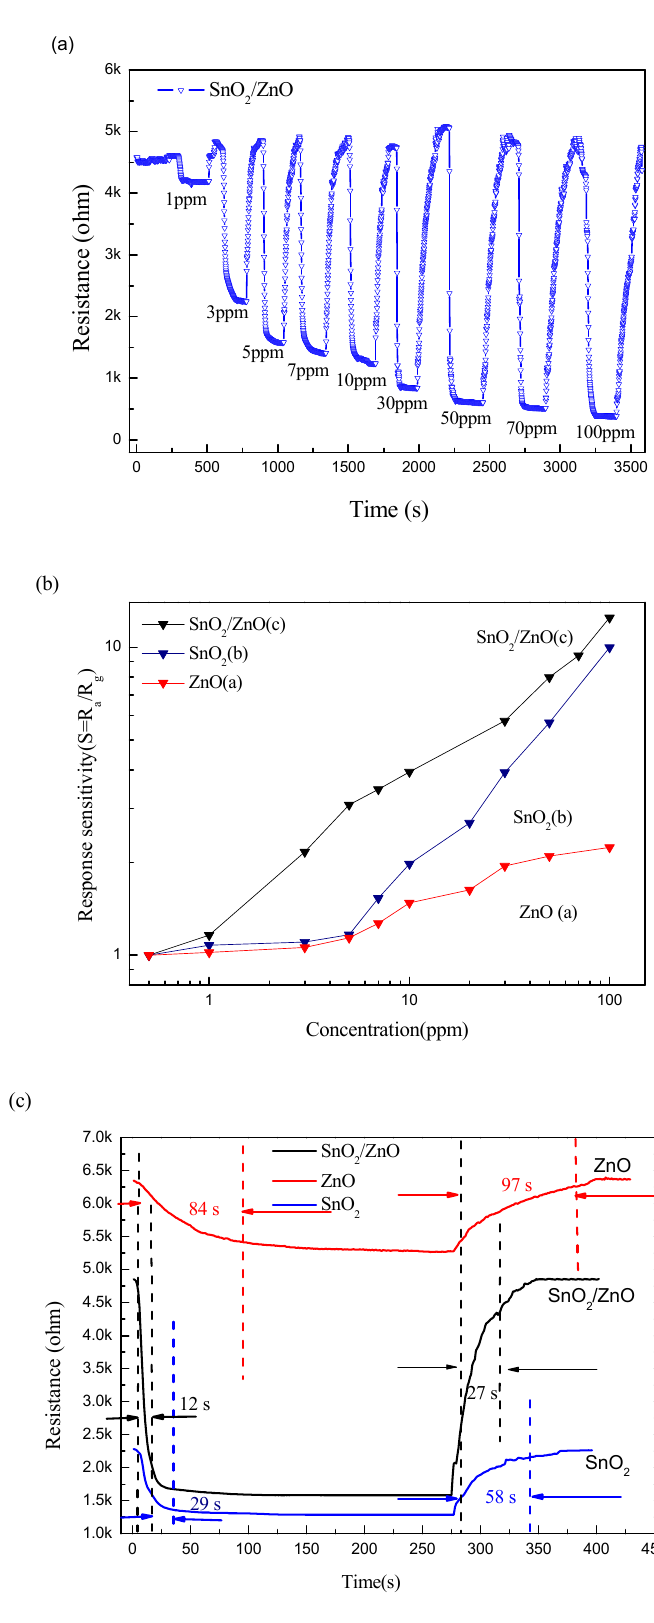
Figure 7. Sensing performance of the SnO 2 /ZnO sensor response to acetone. ( a ) Transient responses of the SnO 2 /ZnO sensor to different acetone concentrations. ( b ) Response values of the SnO 2 , ZnO, and SnO 2 /ZnO sensors as a function of acetone concentration. ( c ) The response and recovery times of the SnO 2 , ZnO, and SnO 2 /ZnO sensors to 5 ppm acetone.